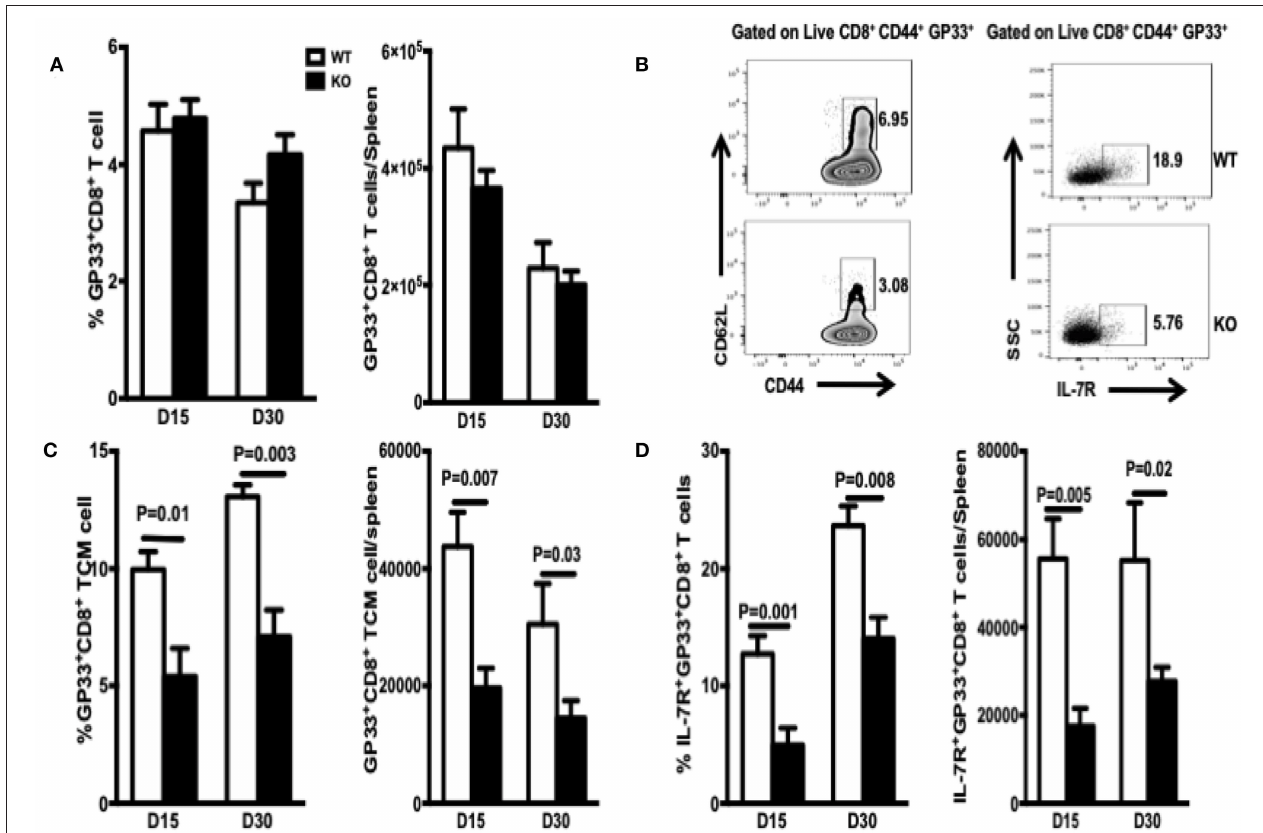
FIGURE 3 | TCM and MEPC numbers in WASp − / − mice fall during the contraction and early memory stages. TCM are defined as CD44 high CD62L high . MEPC are defined as IL-7R high . TCM and MEPC were gated on CD44 + GP33 + CD8 + T cells. (A) Percentages of GP33-specific cells within the CD8 + T cell population (left panel) and absolute number of GP33-specific CD8 + T cells in the spleen (right panel). (B) Left panel: representative data for TCM on D15; right panel, representative data for MEPC on D15. (C) Percentages of TCMs within the GP33-specific CD8 + T cell population and absolute number of GP33-specific TCMs in the spleen. (D) Percentage of MEPCs within the GP33-specific CD8 + T cell population and absolute number of GP33-specific MEPC in the spleen. Data are expressed as the mean ± SEM ( n = 5 mice per group) and were analyzed using an unpaired t